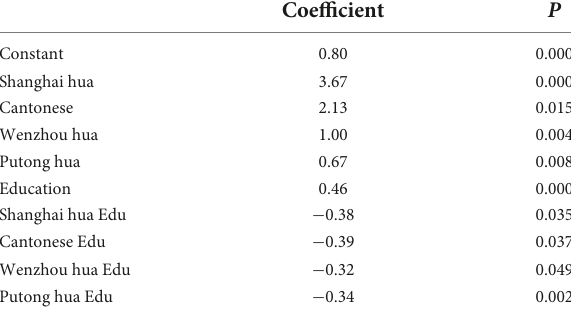
TABLE 8 Moderation effect of educational motivation.